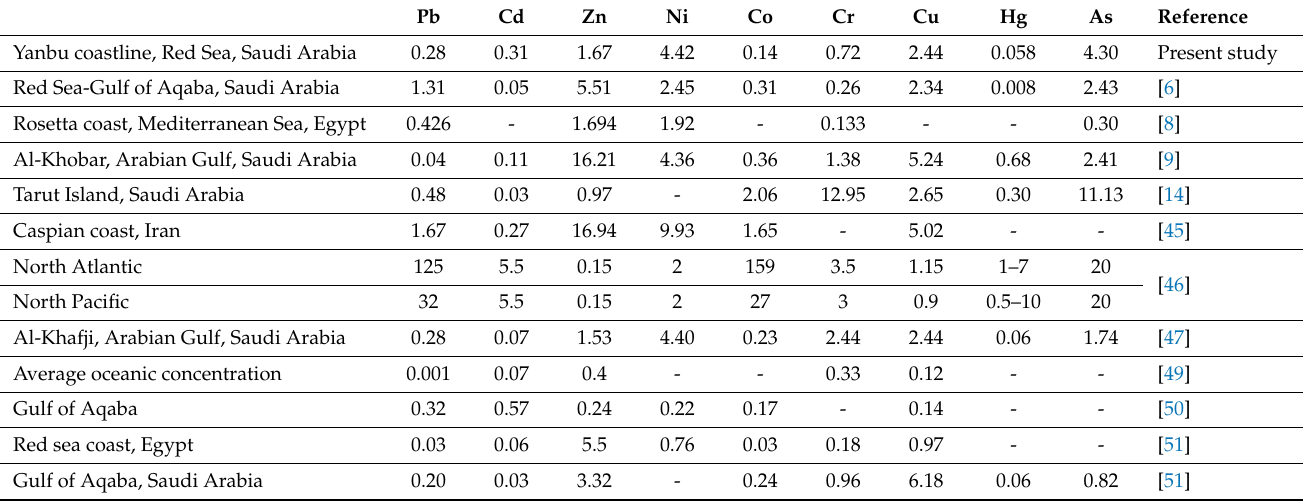
Table 2. HMs levels ( µ g/L) reported in this study as compared to values reported worldwide. Pb Cd Hg As